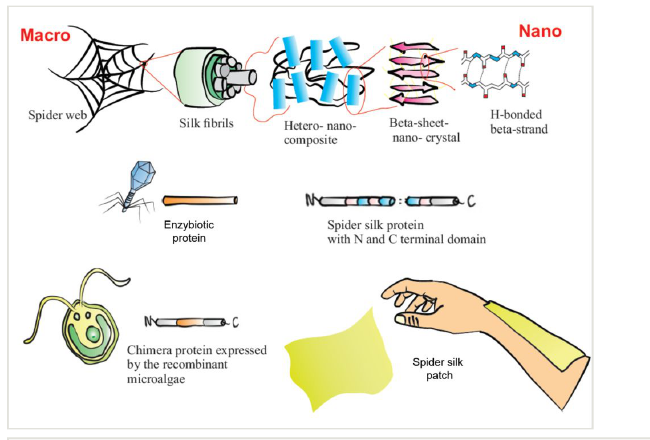
Figure 1. Project overview. Schematic representation of spider web structure from macro to nano scale. A representation of: enzybiotic protein from a bacteriophage; a spider silk protein with repetitive domains and N and C terminals; host expression system Chlamydomonas reinhardtii and a chimeric protein envisioned in this project; and the fi nal product, a biopatch produced from recombinant silk proteins and chimeric